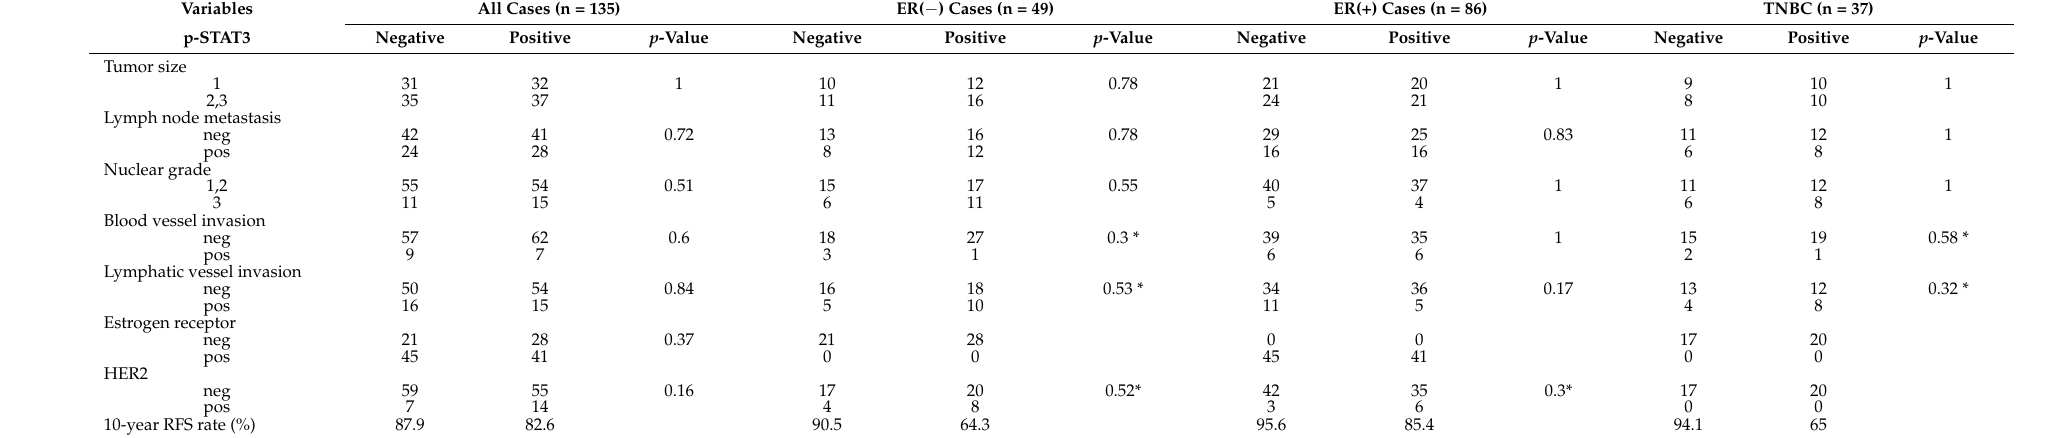
Table 3. Correlation between p-STAT3 expression and pathological factors in all cases, ER( − ) cases, ER(+) cases and TNBC cases.